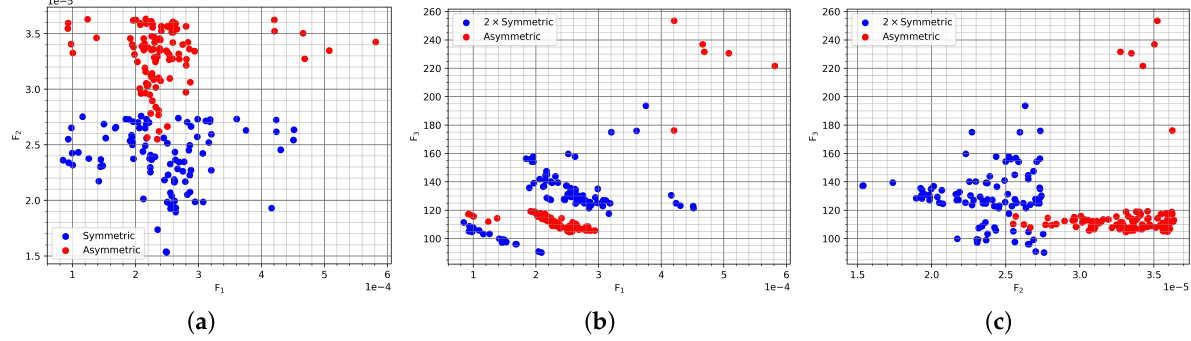
Figure 8. The first 100 individuals from the three-dimensional Pareto front were sorted based on their robustness ( F 2 ) in case ( a ). The blue dots show the symmetric setups, while the asymmetric solutions are depicted in red. ( a ) The distribution of individuals on the F 1 – F 2 axis. ( b ) The distribution on the F 1 – F 3 axis. ( c ) The distribution on the F 2 – F 3